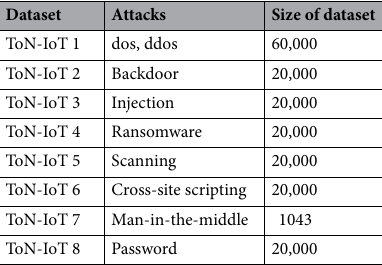
Table 1. Description of IoT datasets.